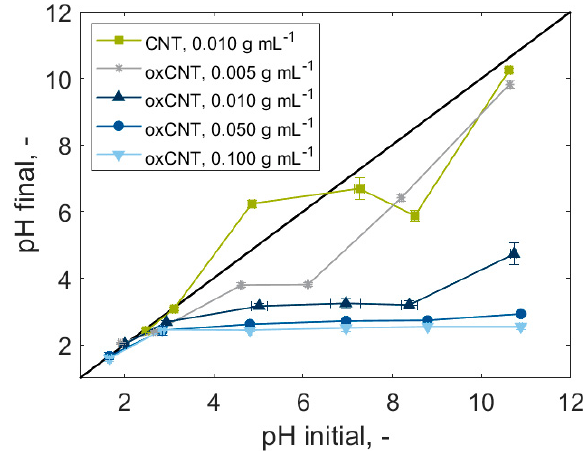
Figure 3. pH-shift experiments for untreated (green) and oxidized CNT-K (blue, grey) particles at differing concentrations. The nanotubes were weighed in as dry mass. Incubation was conducted at RT for 24 h.